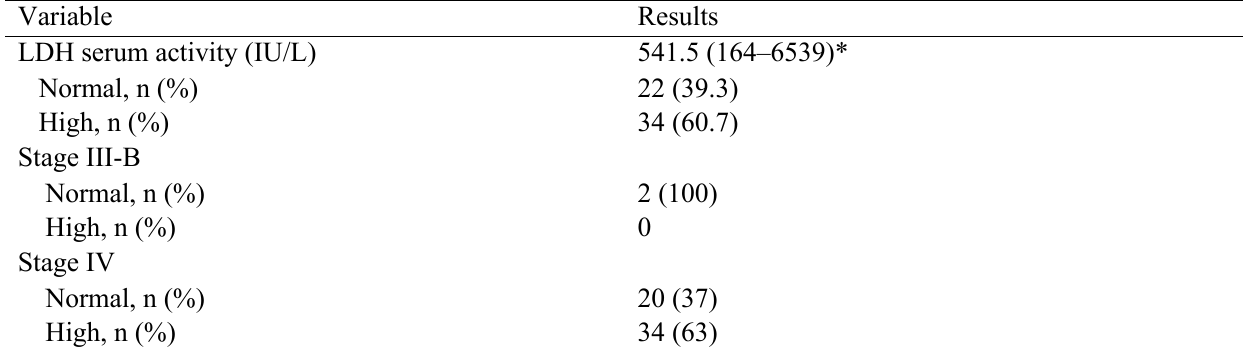
Table 3. Characteristics distribution based on LDH serum activity (n=56)